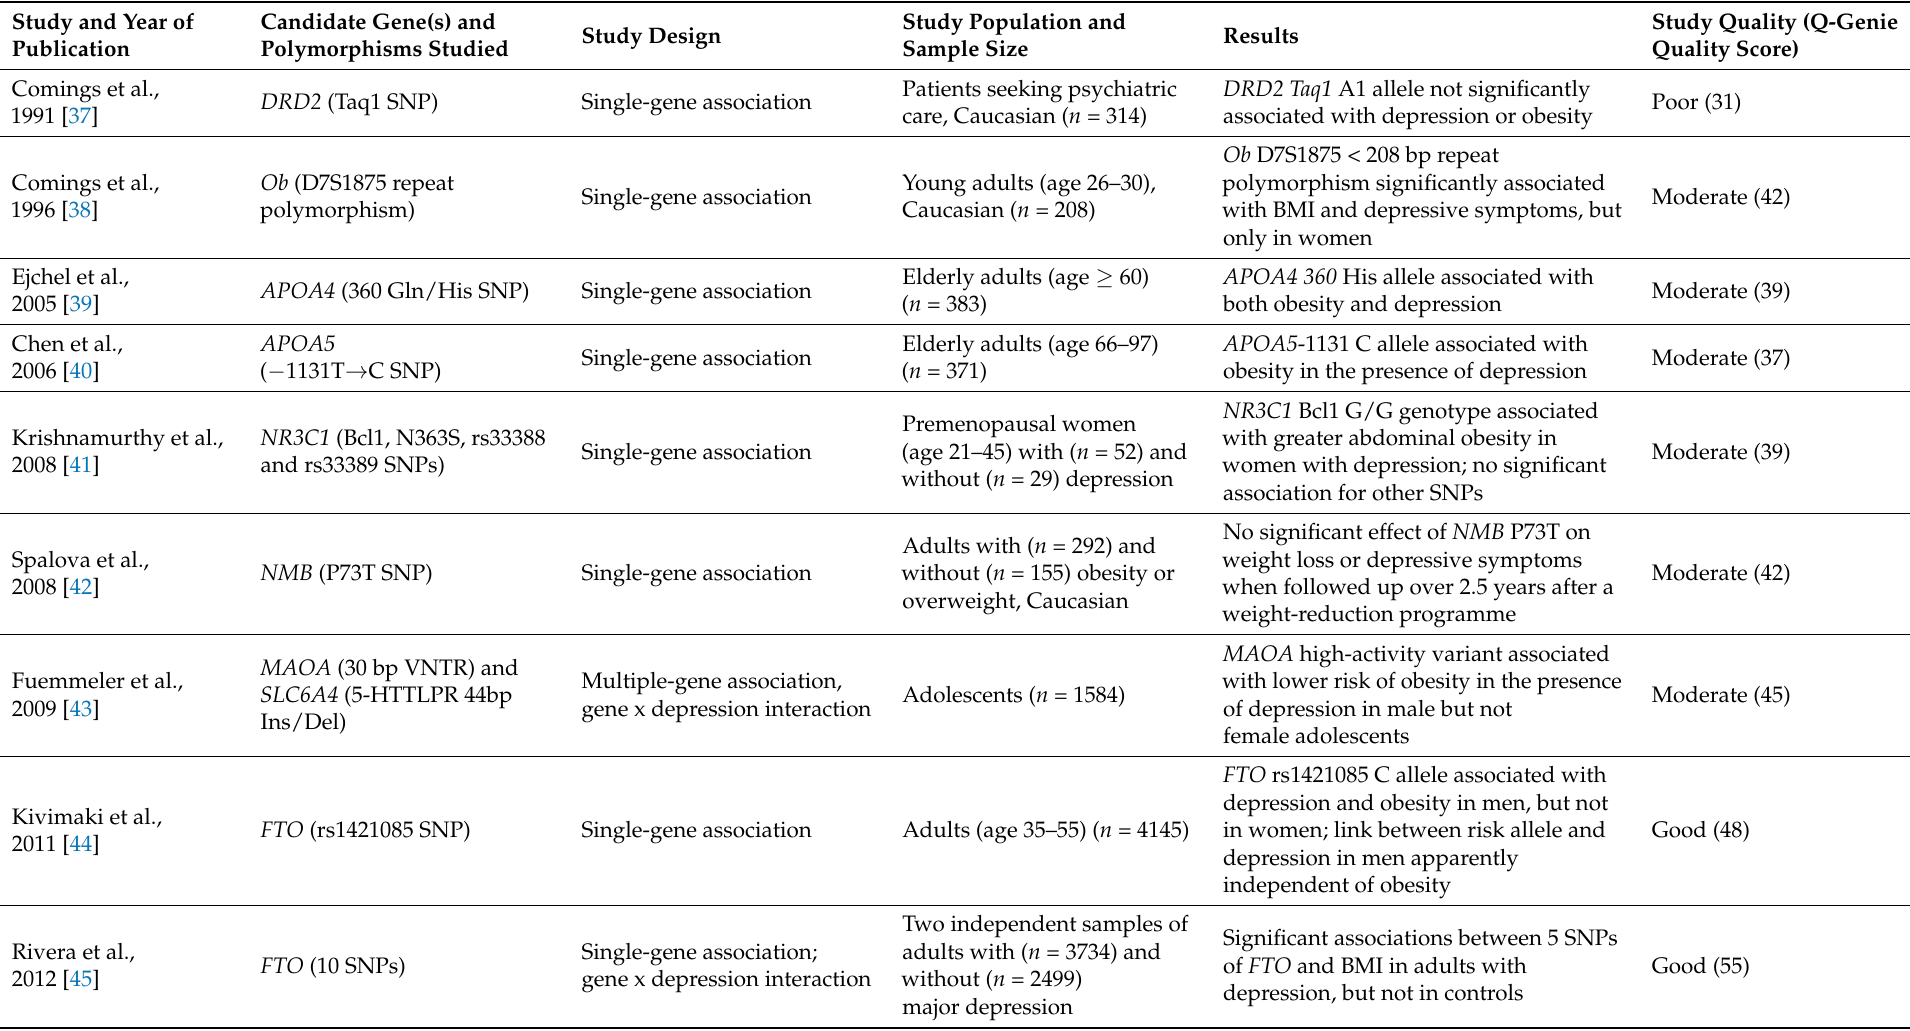
Table 1. Genetic-association studies included in the current